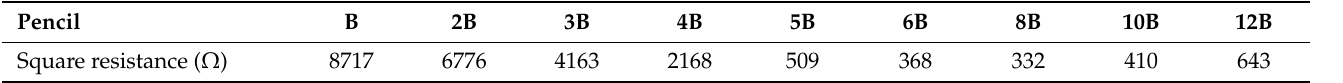
Table 7. The bulk conductance of pencil leads from 1B to 12B and square resistances of pencil trace on the printing paper. The preparation of pencil trace is analogous with the fabrication of electrodes.